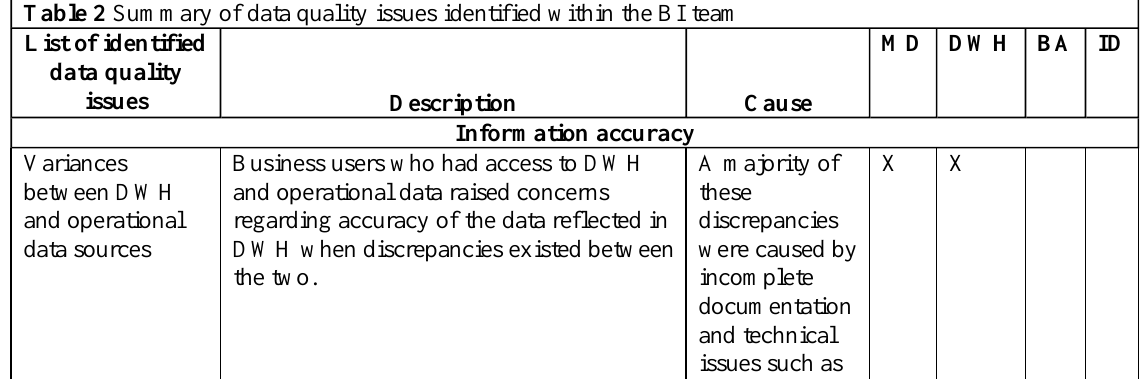
Table 2 Summary of data quality issues identified within the BI